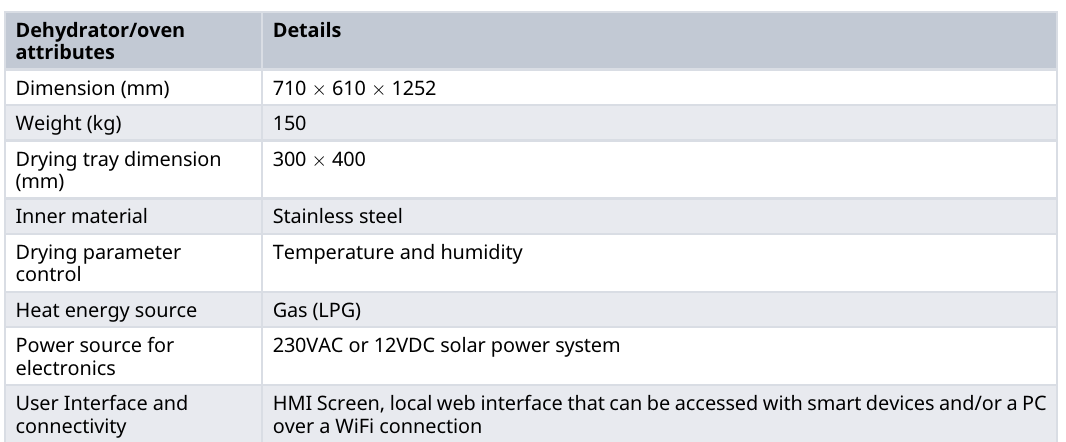
Table 1. The mechanical specifications of the dehydrator.